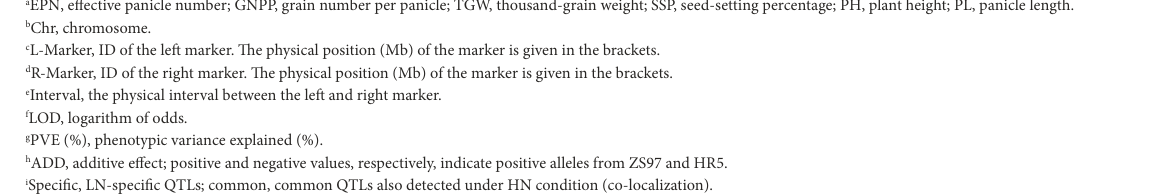
(Supplementary Table S2), comprising three for GNPP, two for TGW, and three for PH, which might be related to the N response.